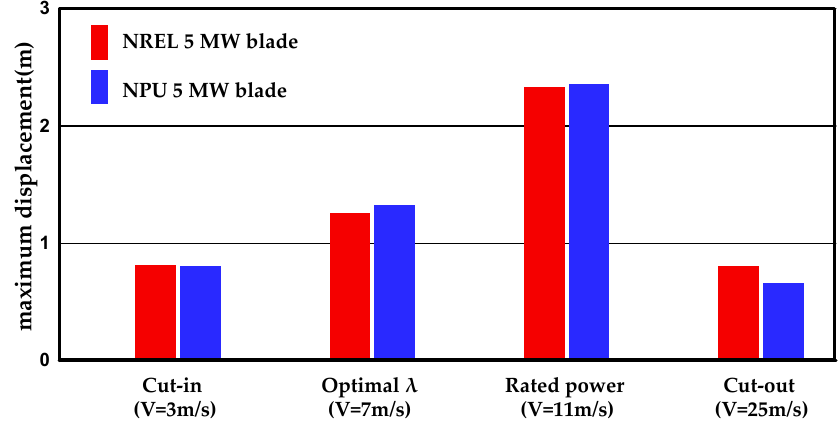
Figure 31. The maximum displacement of blade tip at different working conditions.